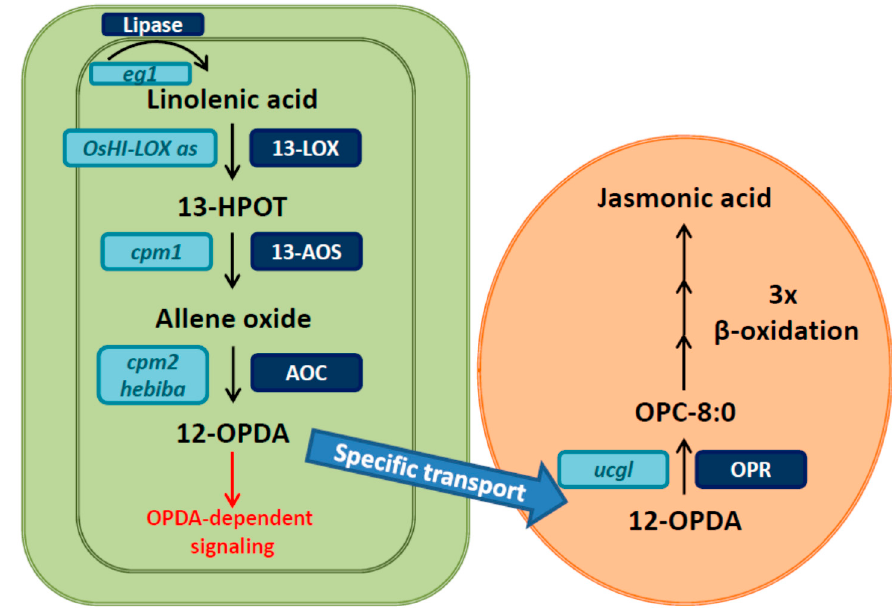
Figure 1. Biosynthesis of JA, major enzymes involved and mutants in the pathway. The biosynthesis occurs in chloroplasts (green) and peroxisomes (brown). In brief, after cleavage of linolenic acid from a membrane lipid it is converted to OPDA in three enzymatic steps. OPDA is a functional signaling compound but can be transported to peroxisomes specifically where it is further metabolized to JA by the action of OPR and subsequent β -oxidation steps. For further explanation, refer to the text. Mutant names are shown in light blue boxes. Extra glume 1 ( eg1 ) is a mutant of a plastidic lipase involved in flower specific JA synthesis. OsHI-LOX antisense plants were found to be impaired in JA-dependent insect responses. A mutant of OsAOS1 , coleoptile photomorphogenesis 1 ( cpm1 ), was isolated as photomorphogenic rice mutant like hebiba and cpm2 , which are mutated in OsAOC . OsOPR7 carries a point-mutation in unclosed glumes ( ucgl ). Abbreviations: 13-LOX: 13-lipoxygenase, 13-HPOT: (13S)-hydroperoxyoctadecatrienoic, 13-AOS: 13-allene oxide